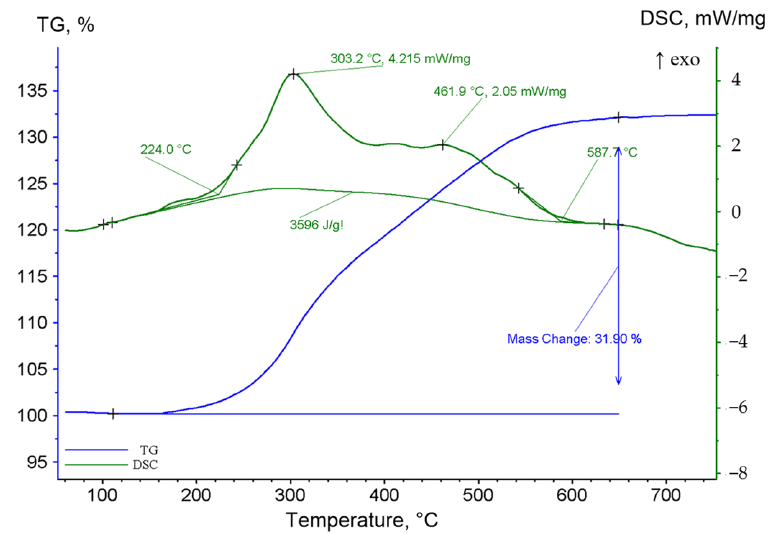
Figure 2. DSC-TG curves of cobalt nanoparticles when heated in an oxygen-containing atmosphere. According to the X-ray phase analysis (Figure 3a), Co nanoparticles (ICDD PDF card No. 00-015-0806) are not oxidised at a temperature of 150 ◦ C; there are no peaks corresponding to cobalt oxides on the diffraction pattern of the sample. Even after heating up to 250 ◦ C, the peaks characteristic for CoO (ICDD PDF card No. 00-048-1719) and Co 3 O 4 (ICDD PDF card No. 00-043-1003) oxides are determined in the samples in addition to the Co peaks. Further heating leads to a decrease in the intensity of the Co peaks in relation to oxides. Complete oxidation of the metal occurs at 600 ◦ C. CoO is also oxidised to Co 3 O 4 at this temperature. Quantitative X-ray phase analysis indicates exponential oxidation of the metal (Figure 3b, Table 1), which may be attributed to the diffusion limitations arising from the growing thickness of the oxide layer on the surface of the reacting particles. Table 1. Quantitative assessment of the content of phases in samples according to X ‐ ray phase analysis. Sample